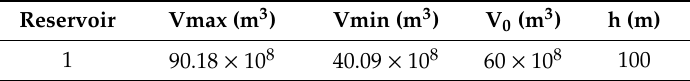
Table 6. The characteristic parameters of the reservoir.